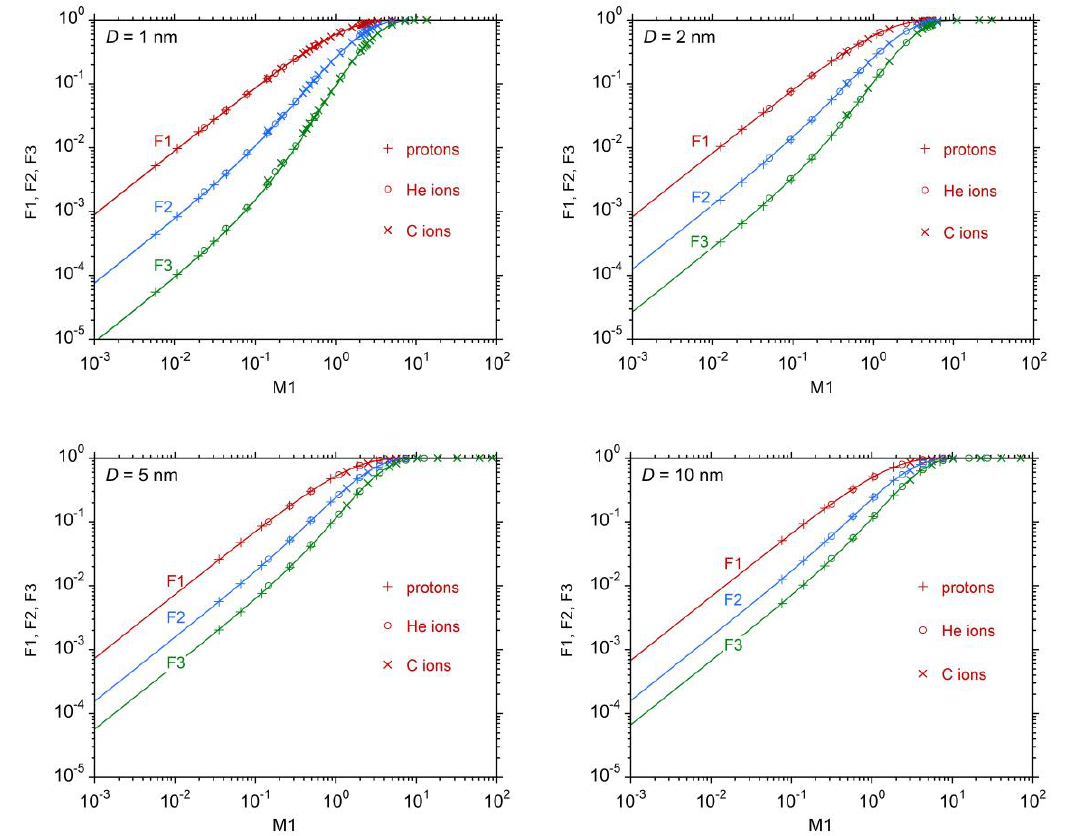
Figure 1. The cumulative probabilities 𝐹 𝑘 , for k = 1, 2, 3, plotted as a function of the mean cluster size 𝑀 1 , for different site sizes. Simulations performed for protons, helium and carbon ions (see legend) at different kinetic energies. Lines are the best fit according to Equations (3) – (5).